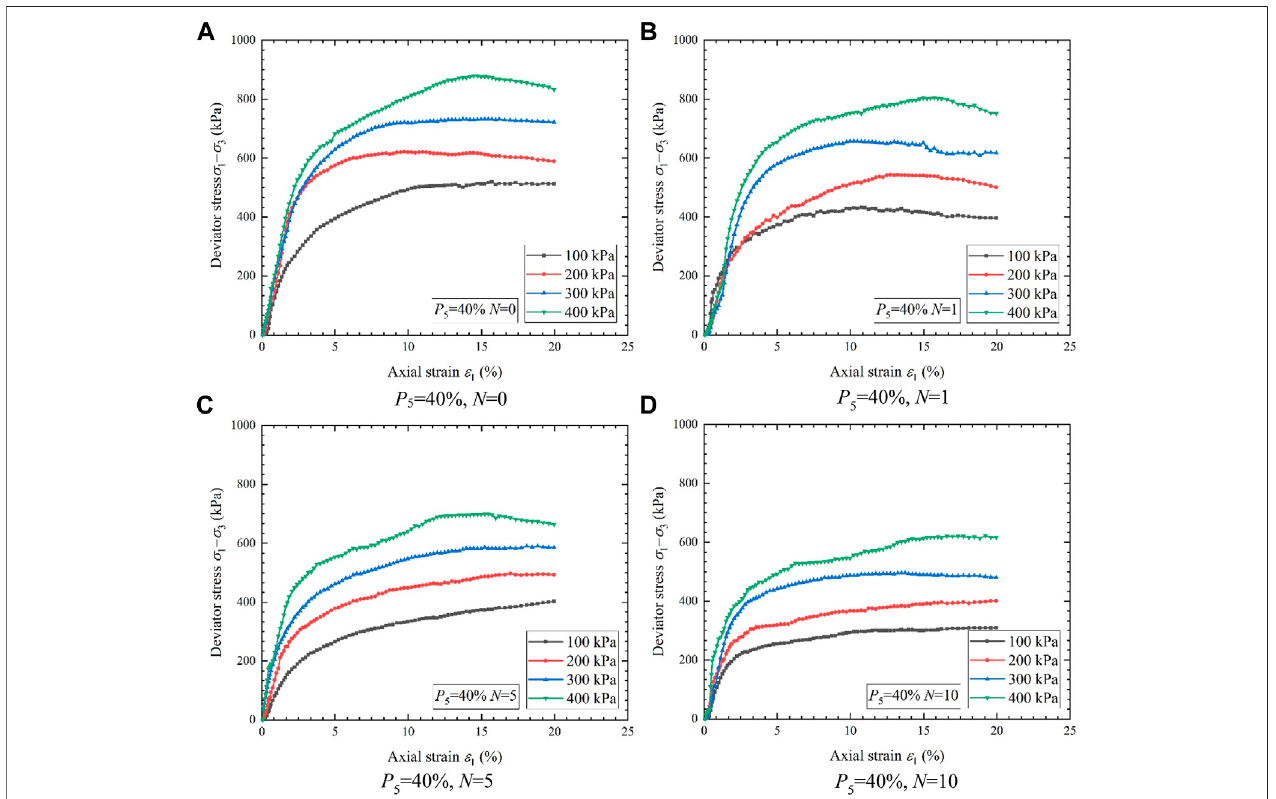
FIGURE 7 | Stress-strain curve of S-RMs after I-AD circulations: (A) P 5 = 40%, N = 0; (B) P 5 = 40%, N = 1; (C) P 5 = 40%, N = 5; (D) P 5 = 40%, N = 10.